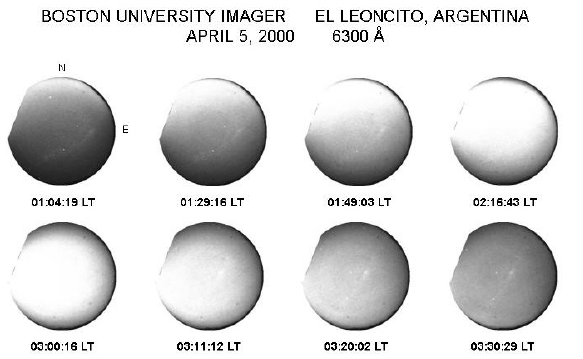
Figure 2. Fig. 2. A series of eight 6300 ˚A all-sky images taken from El Leoncito, Argentina on 5 April 2000 which illustrates the passage of an MBW event. The orientation of the images is such that North and East are at the top and to the right, respectively.